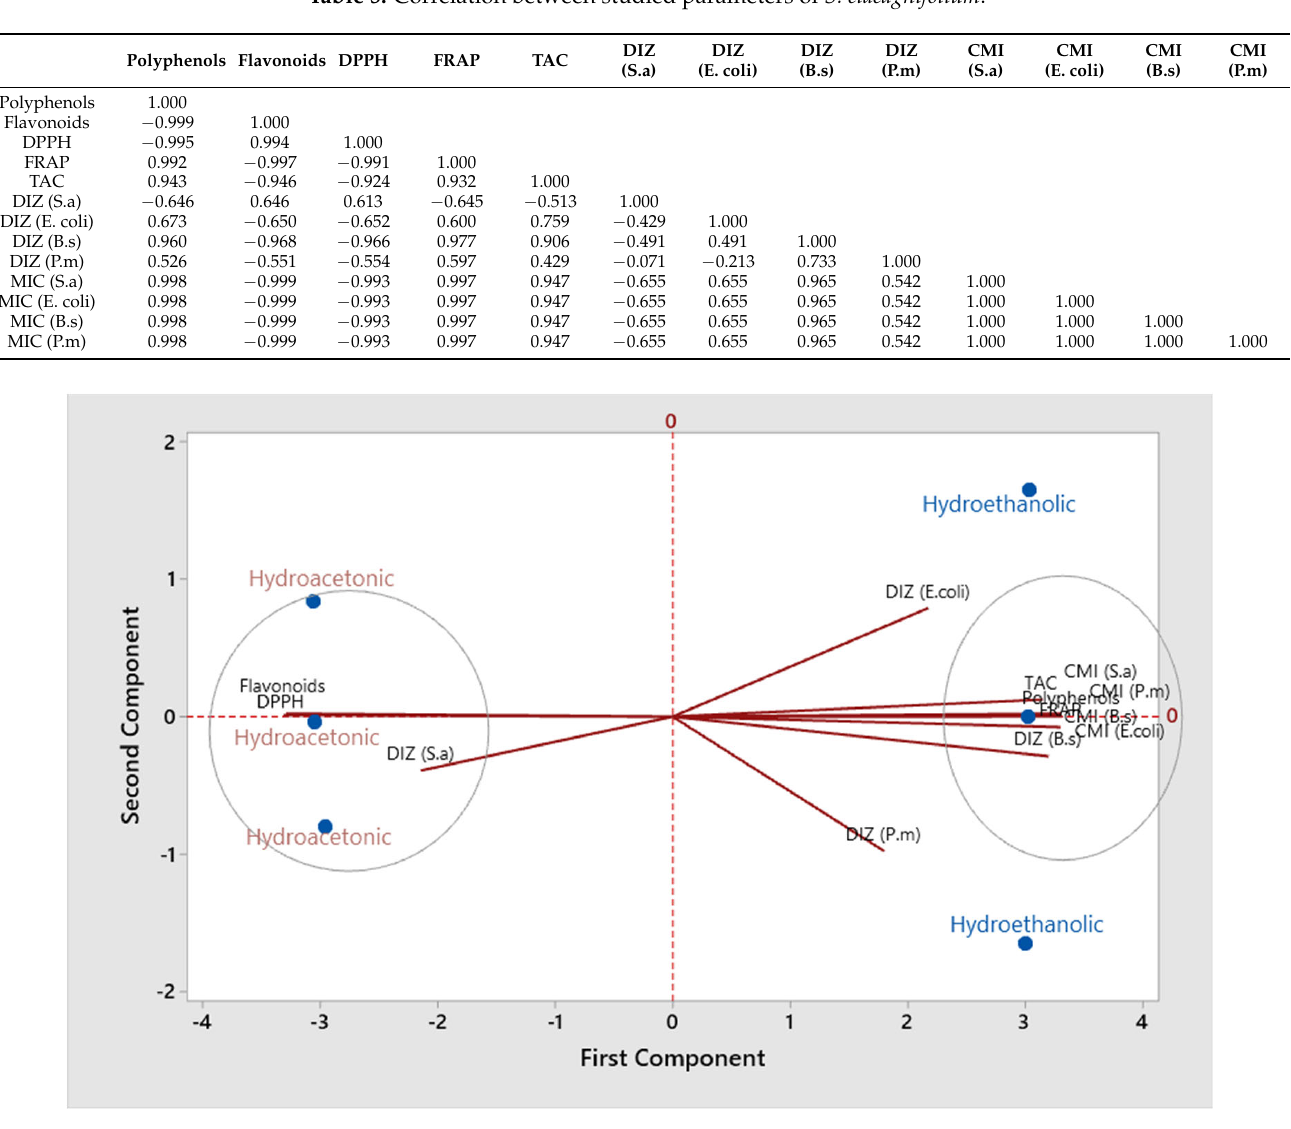
Table 5. Correlation between studied parameters of S. elaeagnifolium .